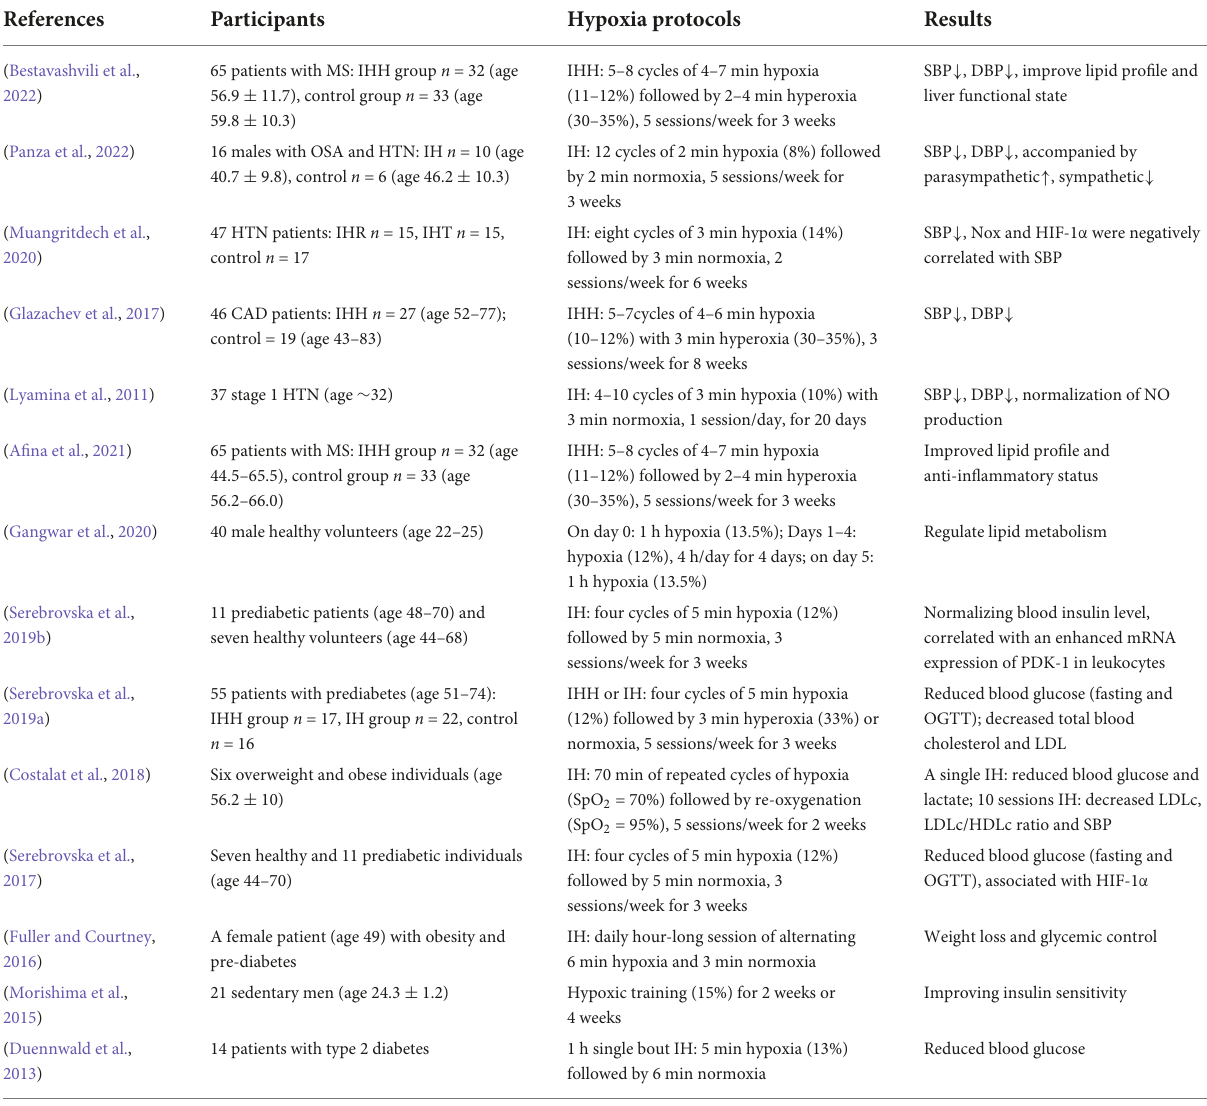
TABLE 1 Effects of intermittent hypoxia on vascular risk factors in